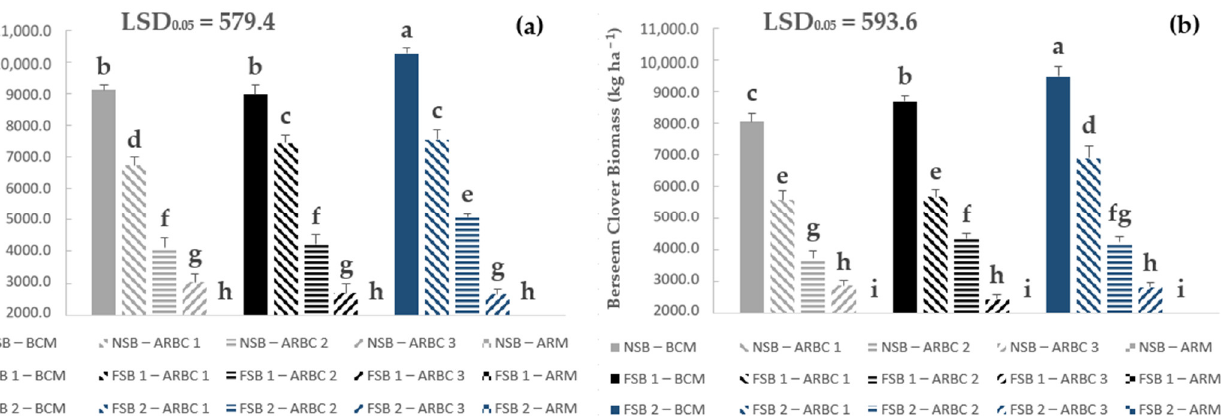
Figure 9. Cumulative biomass of berseem clover (kg ha −1 ) from two harvests in ( a ) 2020–2021 and ( b ) 2021–2022. Data refer to the interaction between seedbed (S) and forage (F) factors. NSB: Normal